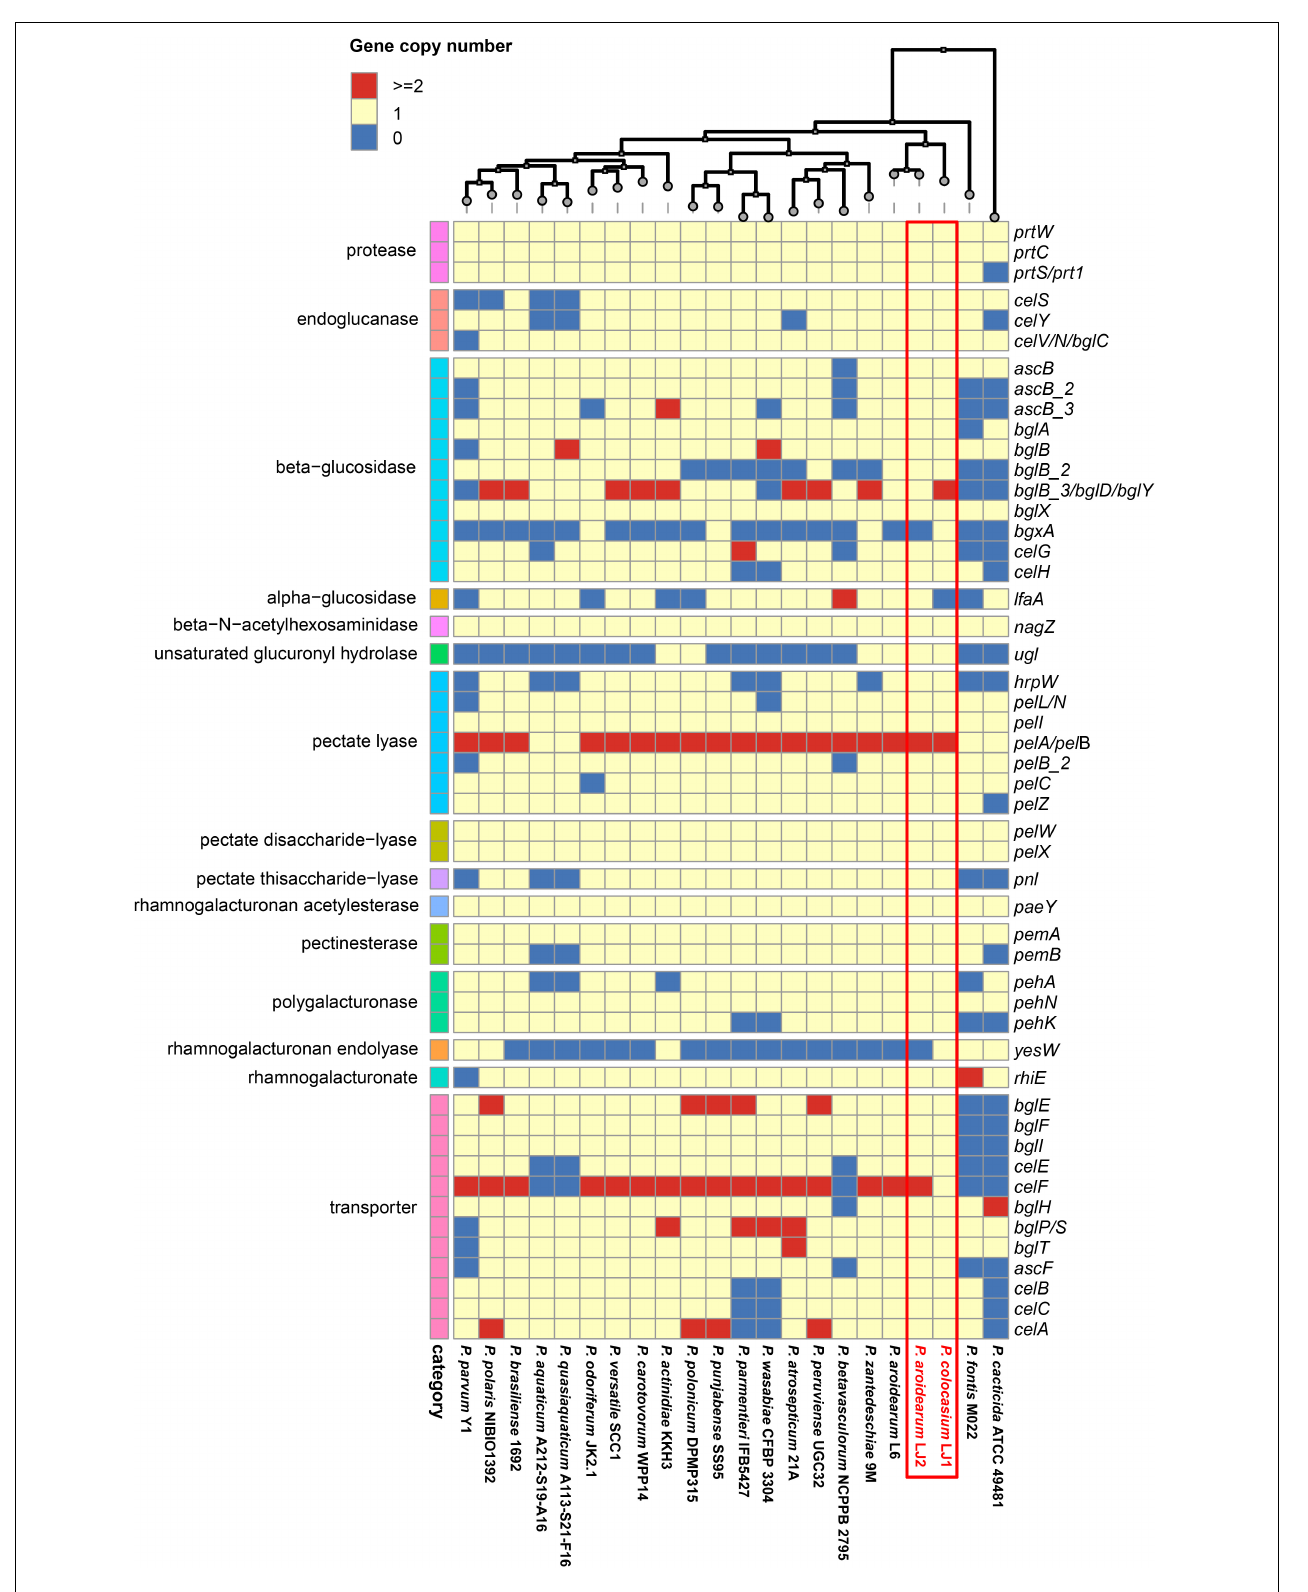
FIGURE 6 | Copy numbers of CWDE-encoding genes in the genomes of Pectobacterium colocasium sp. nov. LJ1, Pectobacterium aroidearum LJ2, and 20 representative Pectobacterium strains. In the heatmap, each row represents a gene and each column represents a strain. The colors of blue, yellow, and red correspond to gene copy numbers of 0, 1, and 2 or more, respectively.